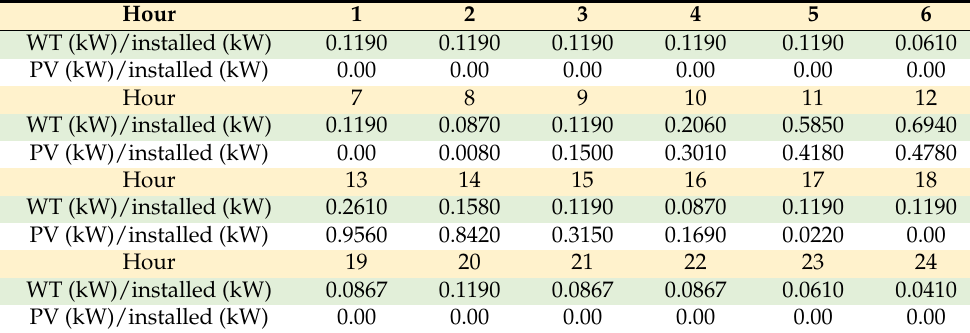
Table 4. Production rate of wind turbine and photovoltaic per one unit of